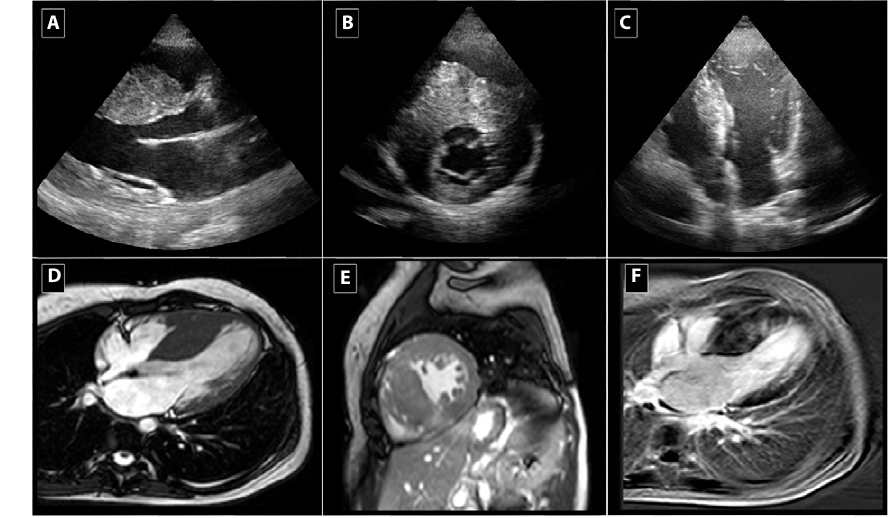
Figure 3. Hypertrophic cardiomyopathy. Echocardiographic and cardiac magnetic resonance images from a 17- year old female patient with HCM. Parasternal long and short axis views show severe LV thickness values (max LV wall thickness 31 mm), with redundant mitral leaflets (panels A, B and D) and small cavity size. Apical 4 chambers view shows massive hypertrophy of the septum and the antero-lateral wall (panels C and E). Image of late gadolinium enhancement showing limited and nontransmural area of fibrosis of the IVS (panel F: black arrow). Abbreviations: LV = left ventricle, RV = right ventricle IVS = inter-ventricular septum. The distribution of hypertrophy is usually asymmetric and sometimes confined to one or two LV segments. As a consequence, LV mass (measured by CMR) can be within the normal range. LV